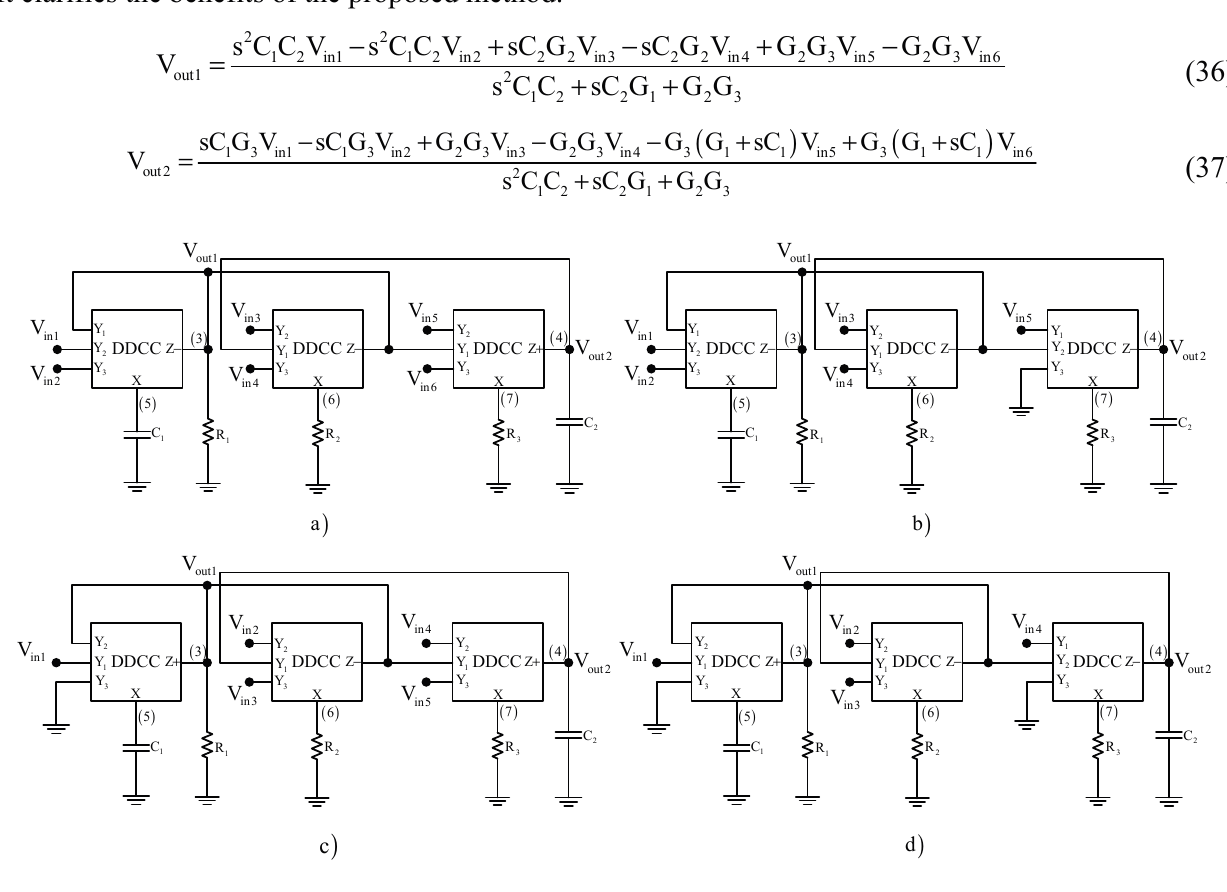
Figure 7. The practical configuration of type-B